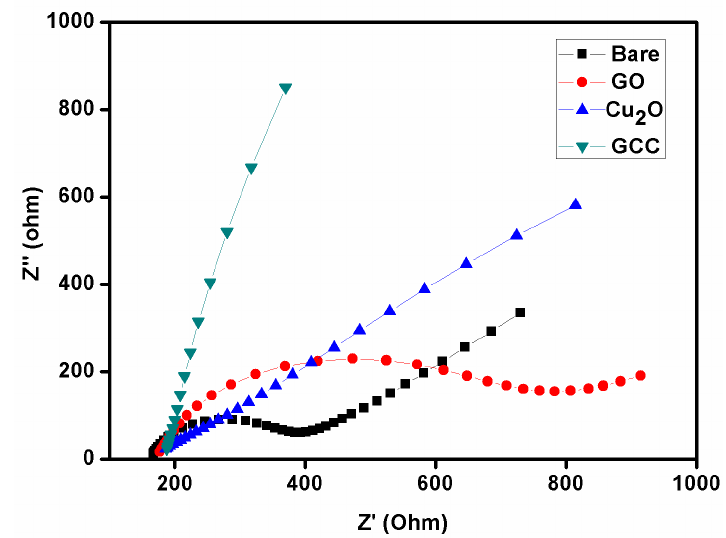
Figure 9. EIS spectra of Bare, GO, Cu 2 O, and GCC